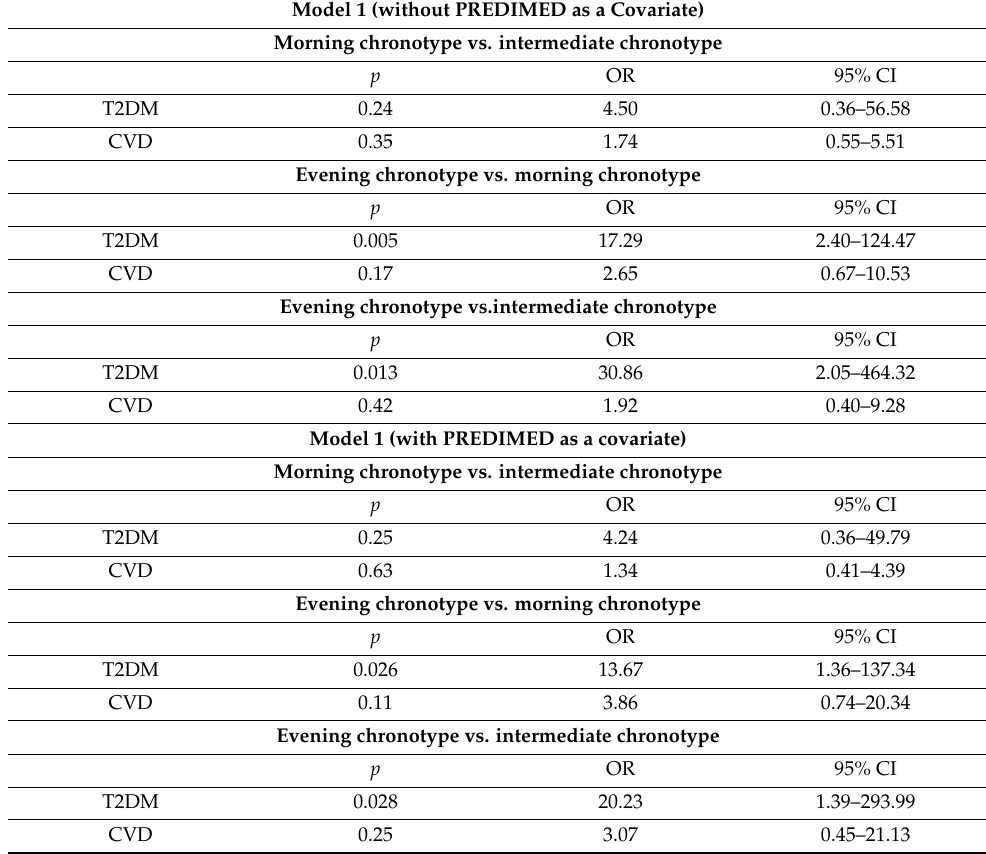
Table 2. Association of chronotype categories with T2DM and